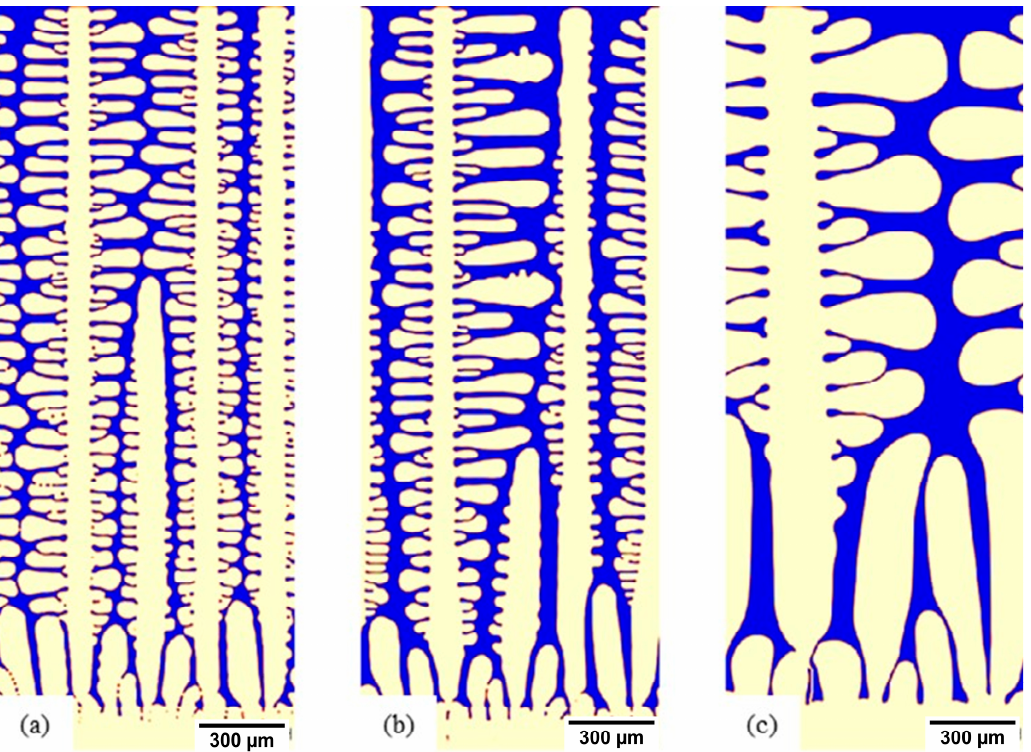
Figure 12. S32101, 100 °C superheated microstructure showing the development of SDAs: ( a ) chill surface, ( b ) 10 mm in the slab, and ( c ) 50 mm in the slab.